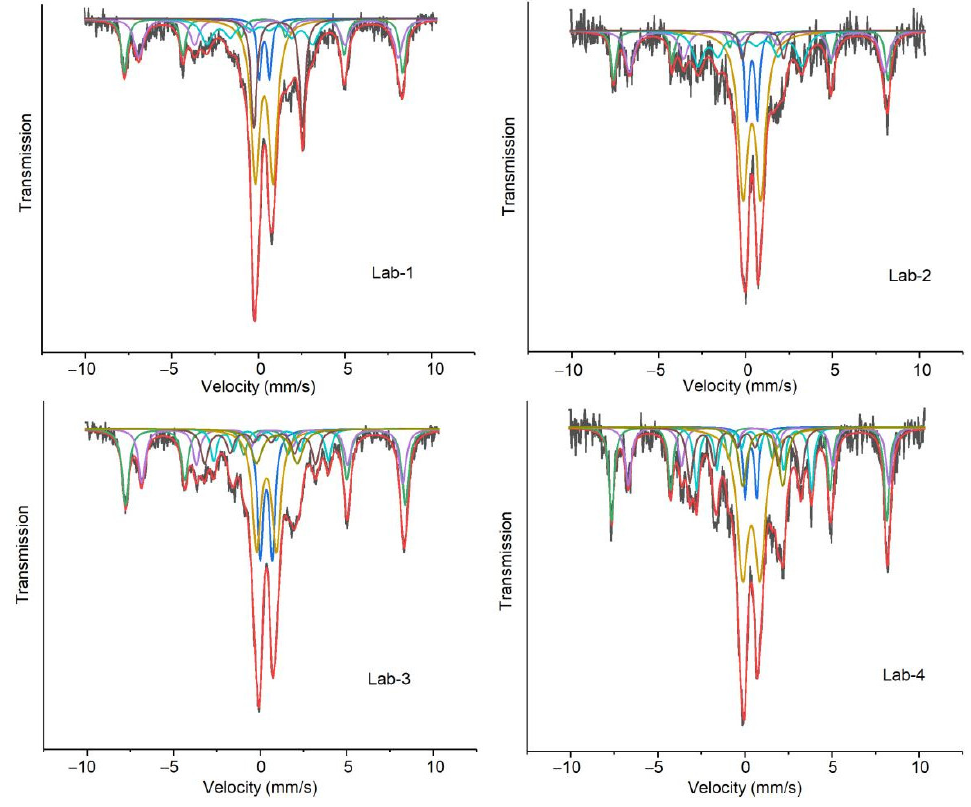
Figure 15. MES spectra of samples after FTS reaction. Table 5. MES spectrum analysis results of four spent catalysts with different potassium contents after the FTS reaction.